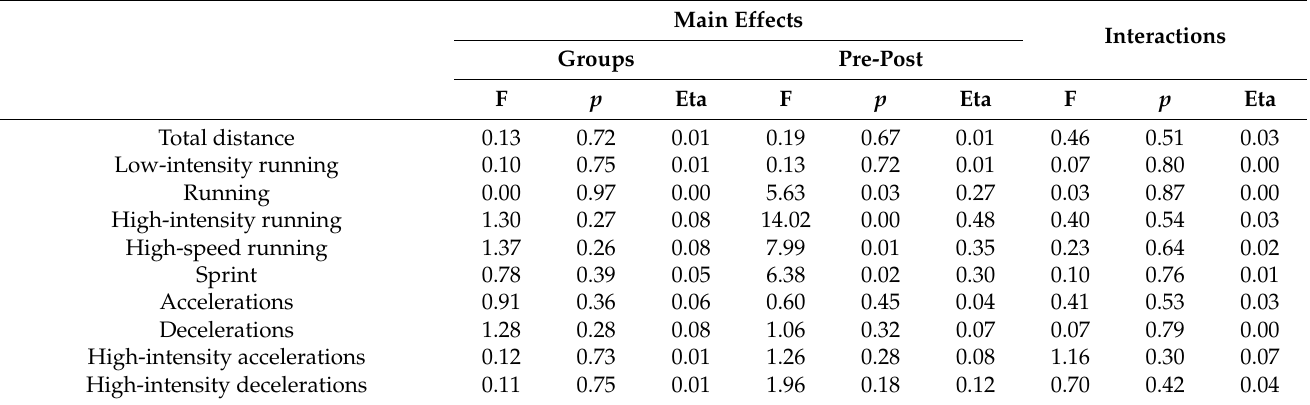
Table 4. Repeated measures of match running